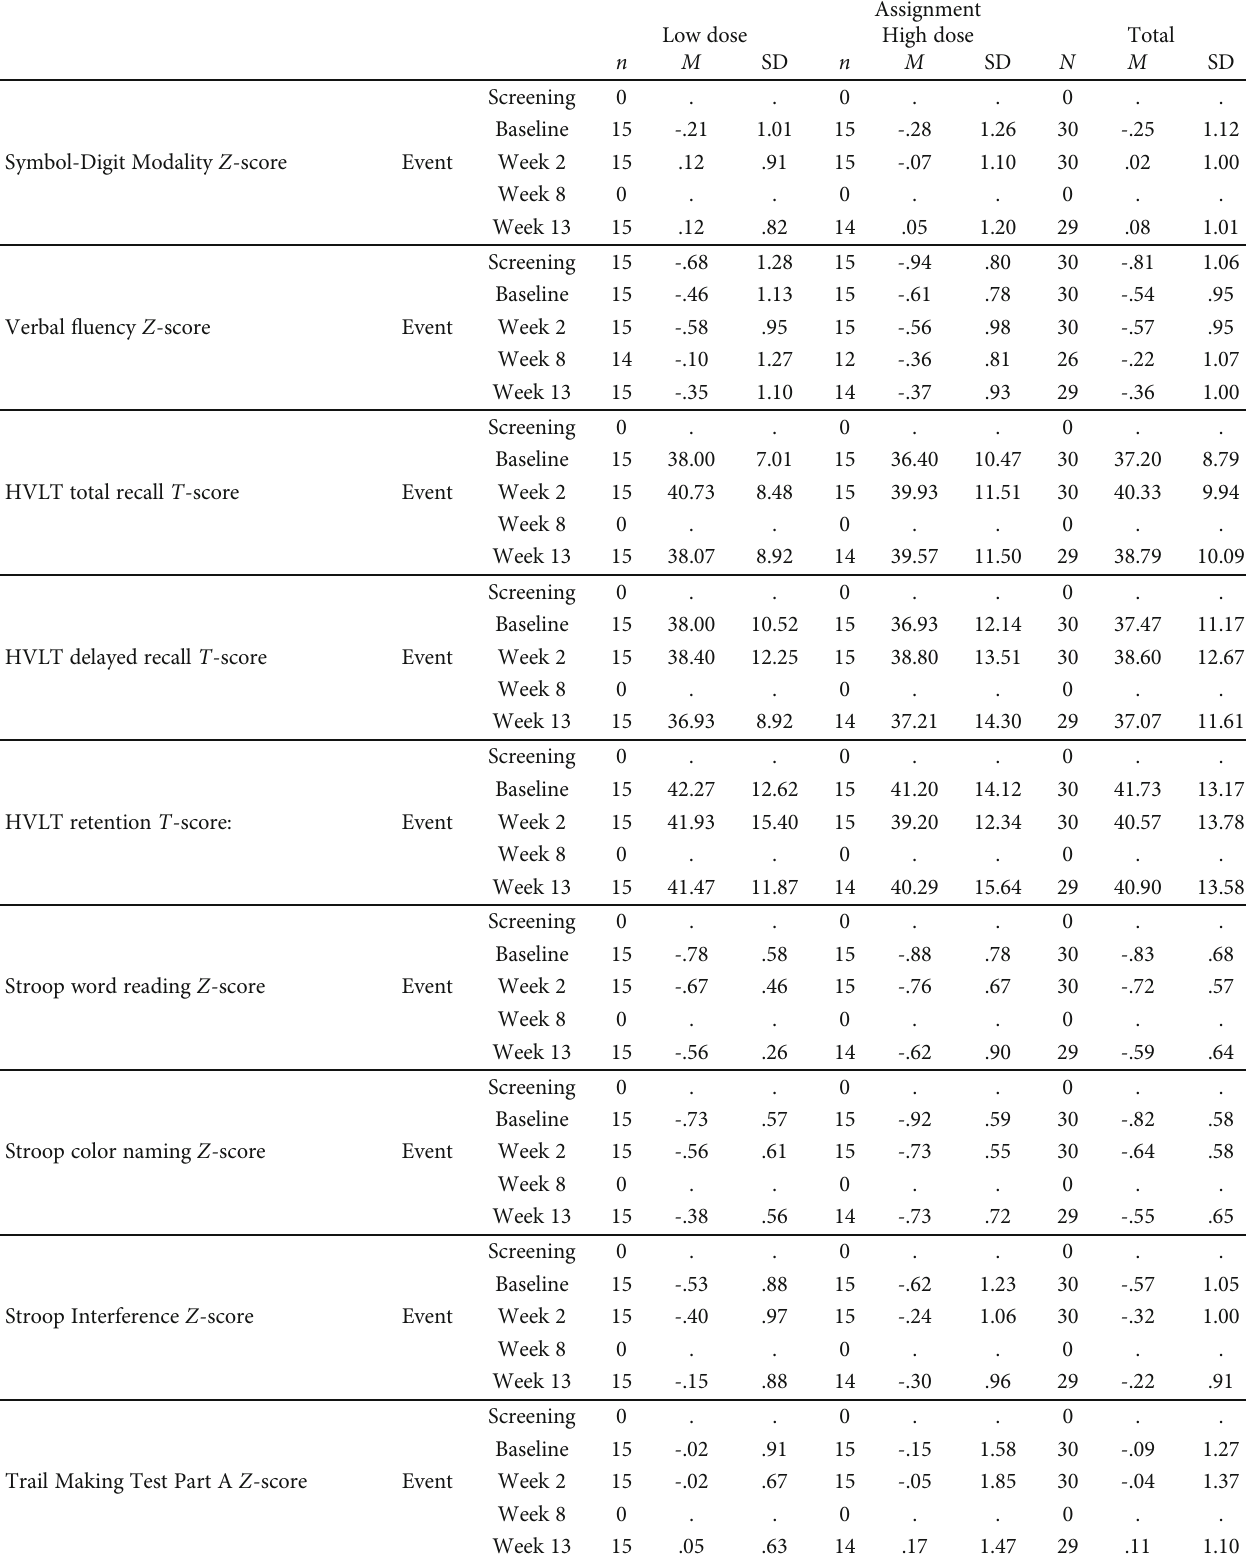
Table 2: Summary statistics for cognitive test